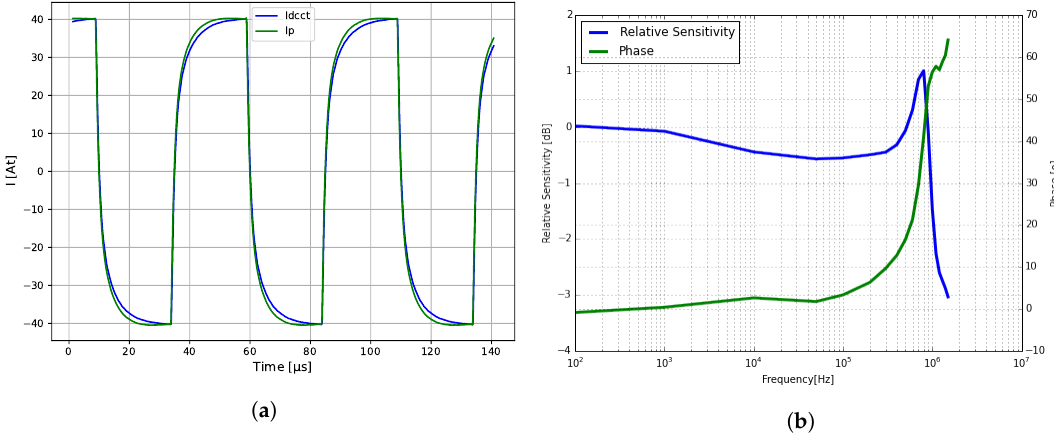
Figure 12. AC response of the 40A9R. ( a ) Large step response of the 40A9R core; ( b ) Small signal bandwidth, 15% I p until 100 kHz, and 3% I p at 1